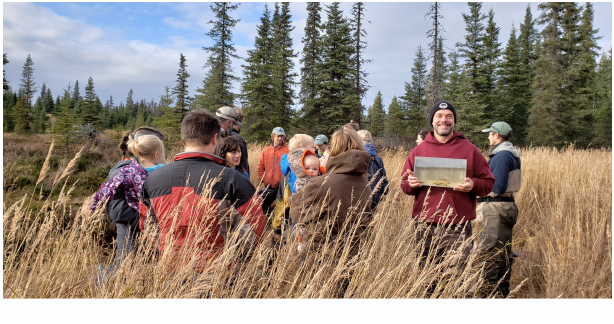
are reliant on resources that might be protected by